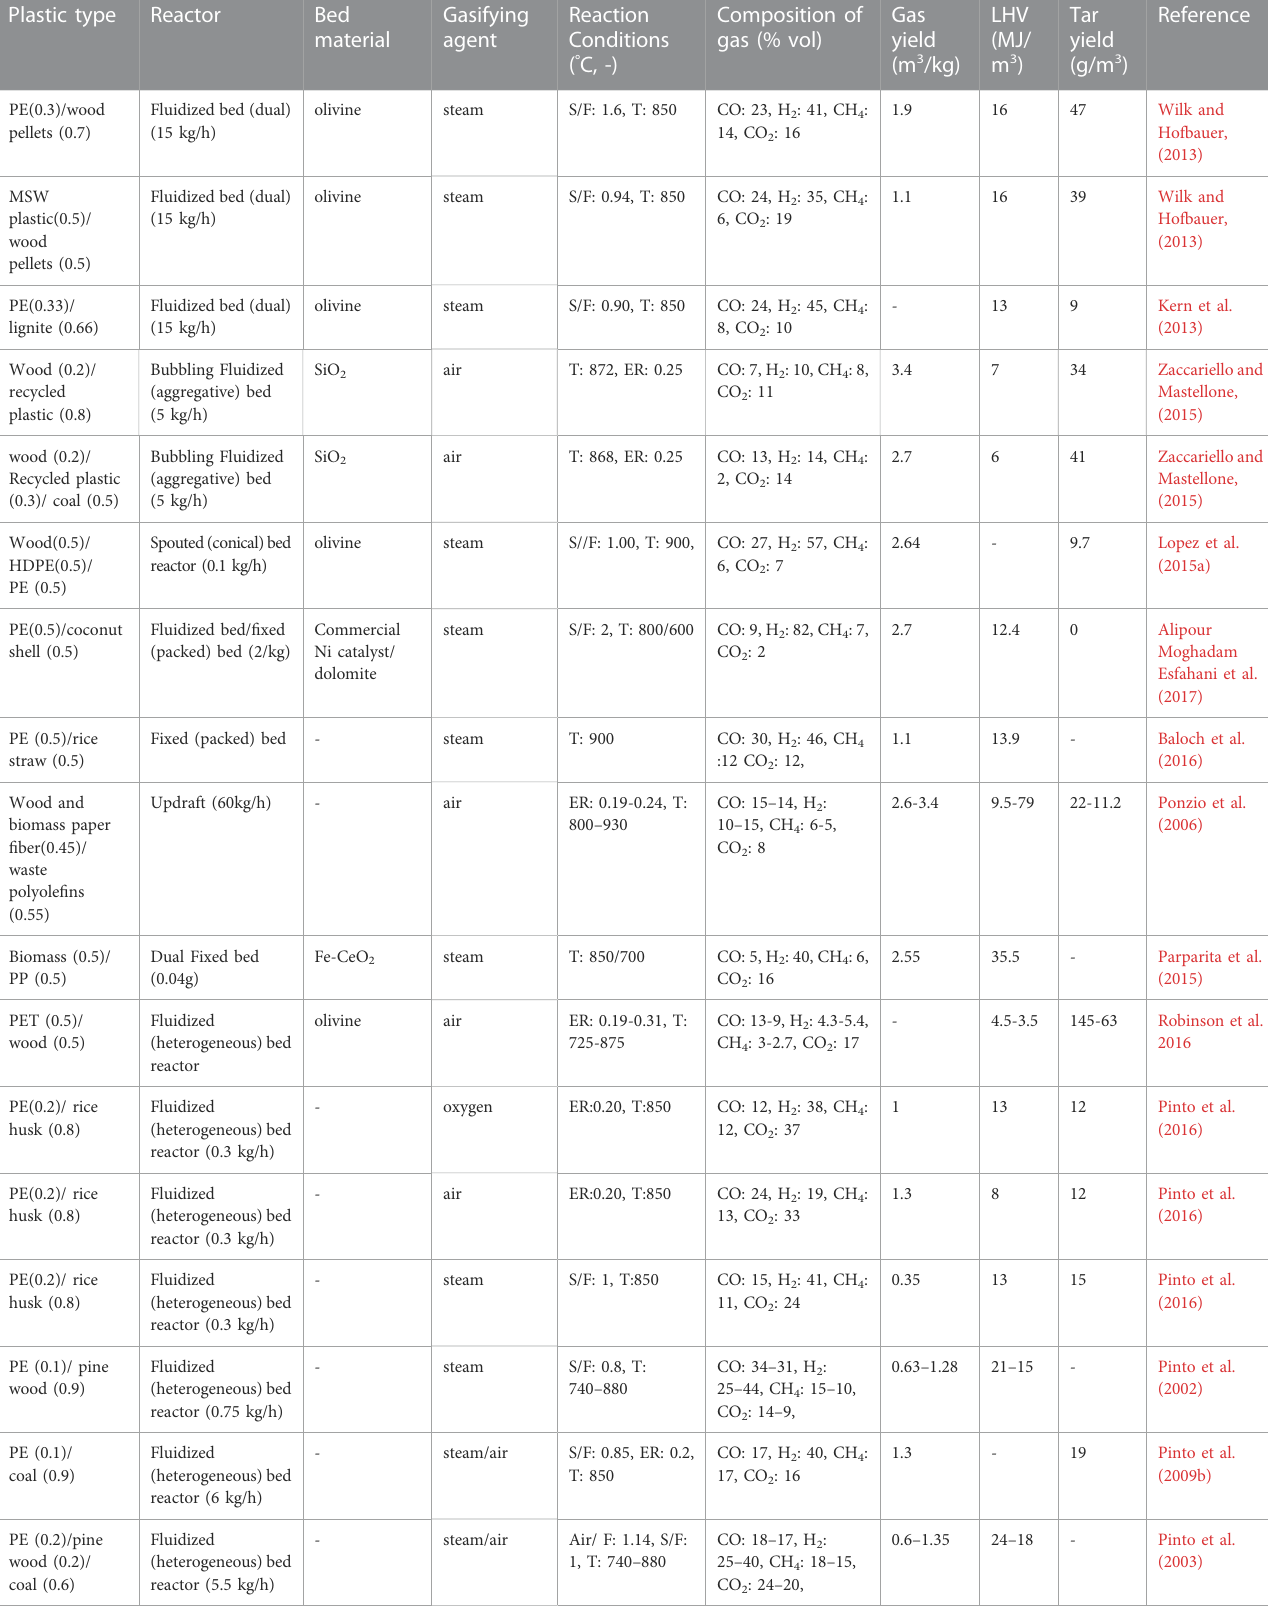
TABLE 3 Gas compositions obtained by authors in the plastics waste co-gasi fi cation. Plastic